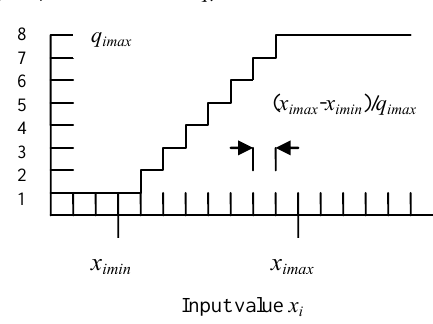
Figure 3. CMAC input